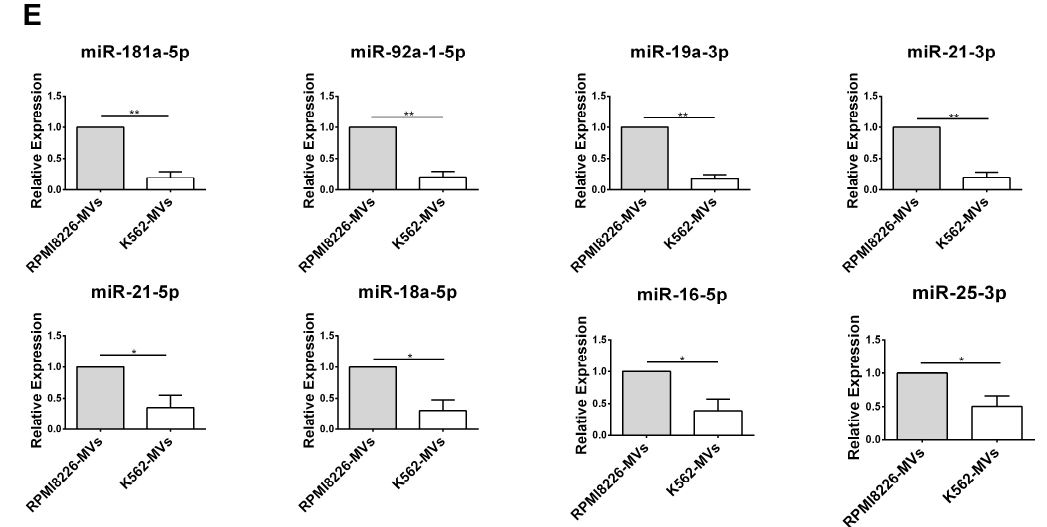
Figure 5. Selective miRNAs in MM-MVs that confer caspase-3-induced apoptosis in HK-2 cells. ( A ) Comparative analysis of renal-pathogenic miRNAs between RPMI8226-MVs and K562-MVs. RPMI8226-MVs were enriched in more highly-expressed renal-pathogenic miRNAs than did K562-MVs; ( B ) The heatmap of renal-protective miRNAs in RPMI8226-MVs and K562-MVs showed low levels of renal-protective miRNAs in the two types of MVs; ( C , D ) A schematic illustration representing MM-MV-packed miRNAs, including renal-pathogenic ( C ) and –protective miRNAs ( D ), and potential targets involved in regulation of caspase-3 in HK-2 cells. Yellow triangles: miRNAs relatively highly represented in RPMI8226-MVs. Green ellipse: caspase 3 gene. Blue rectangles: regulators interacted with hub genes and targeted by miRNAs; ( E ) Evaluation of the levels of the miRNAs involved in the regulation network and differentially expressed between RPMI8226-MVs and K562-MVs, using real-time PCR (* p < 0.01, ** p < 0.05).